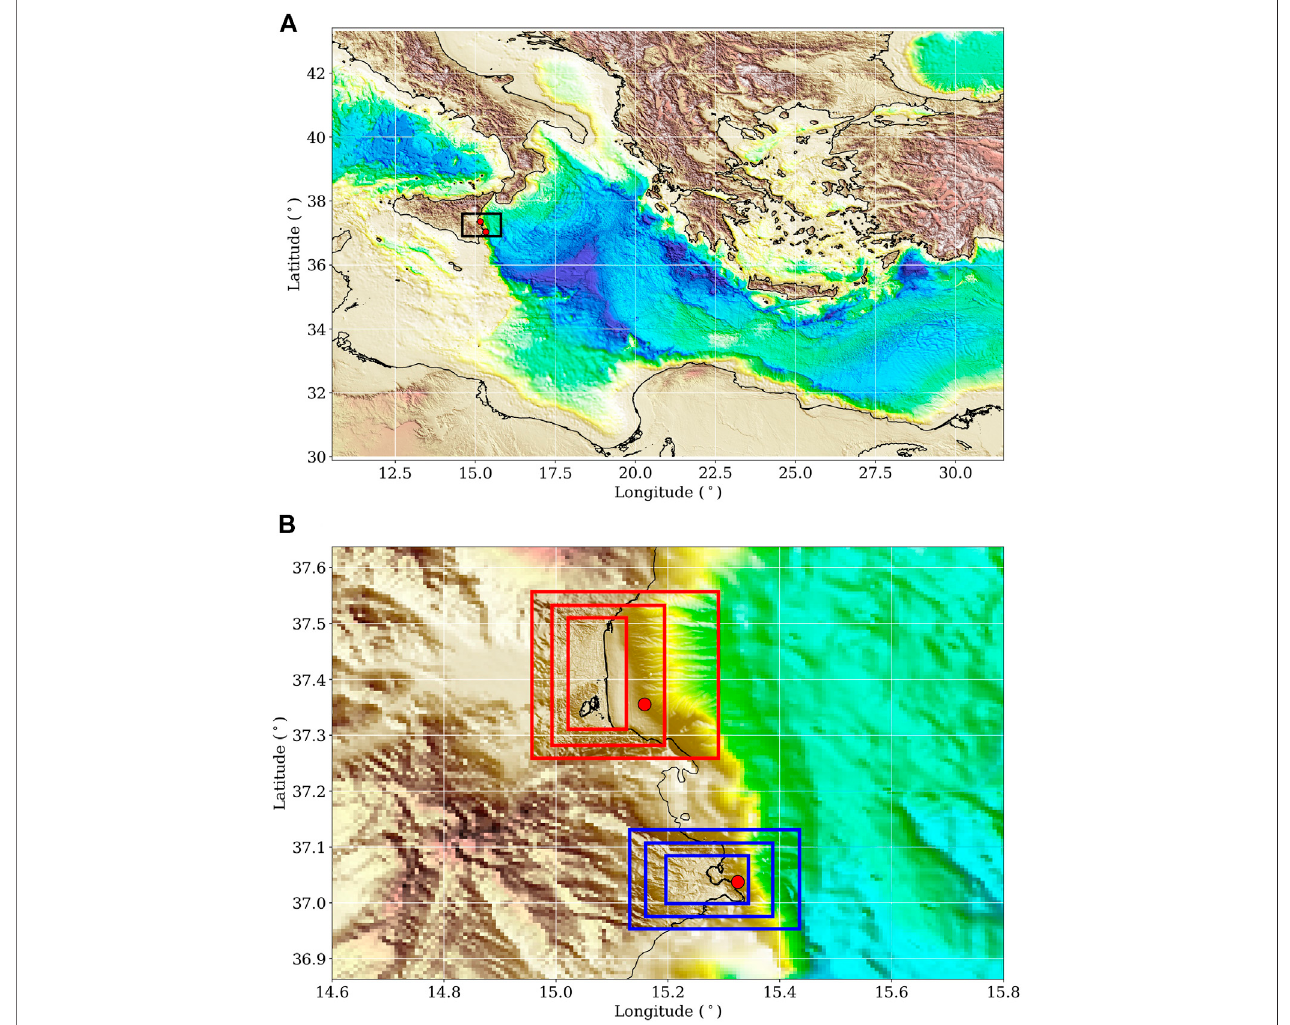
FIGURE8| Extensionofthecomputationaldomain[panel (A) ]showingtheselectedPOIsusedtoperformthedisaggregationanalysis(reddots,asin Figure1 );the targetarea[blackrectangleinthepanel (A) ]iszoomedtoillustratetheinnerlevels(2nd,3rdand4th)ofthenestedgrids[panel (B) ]forinundationmodelinginCatania(red rectangles) and Siracusa (blue rectangles). Grid resolution is 640 m for the larger domain in the top panel and 160, 40 and 10 m for the inner levels shown in the bottom panel.